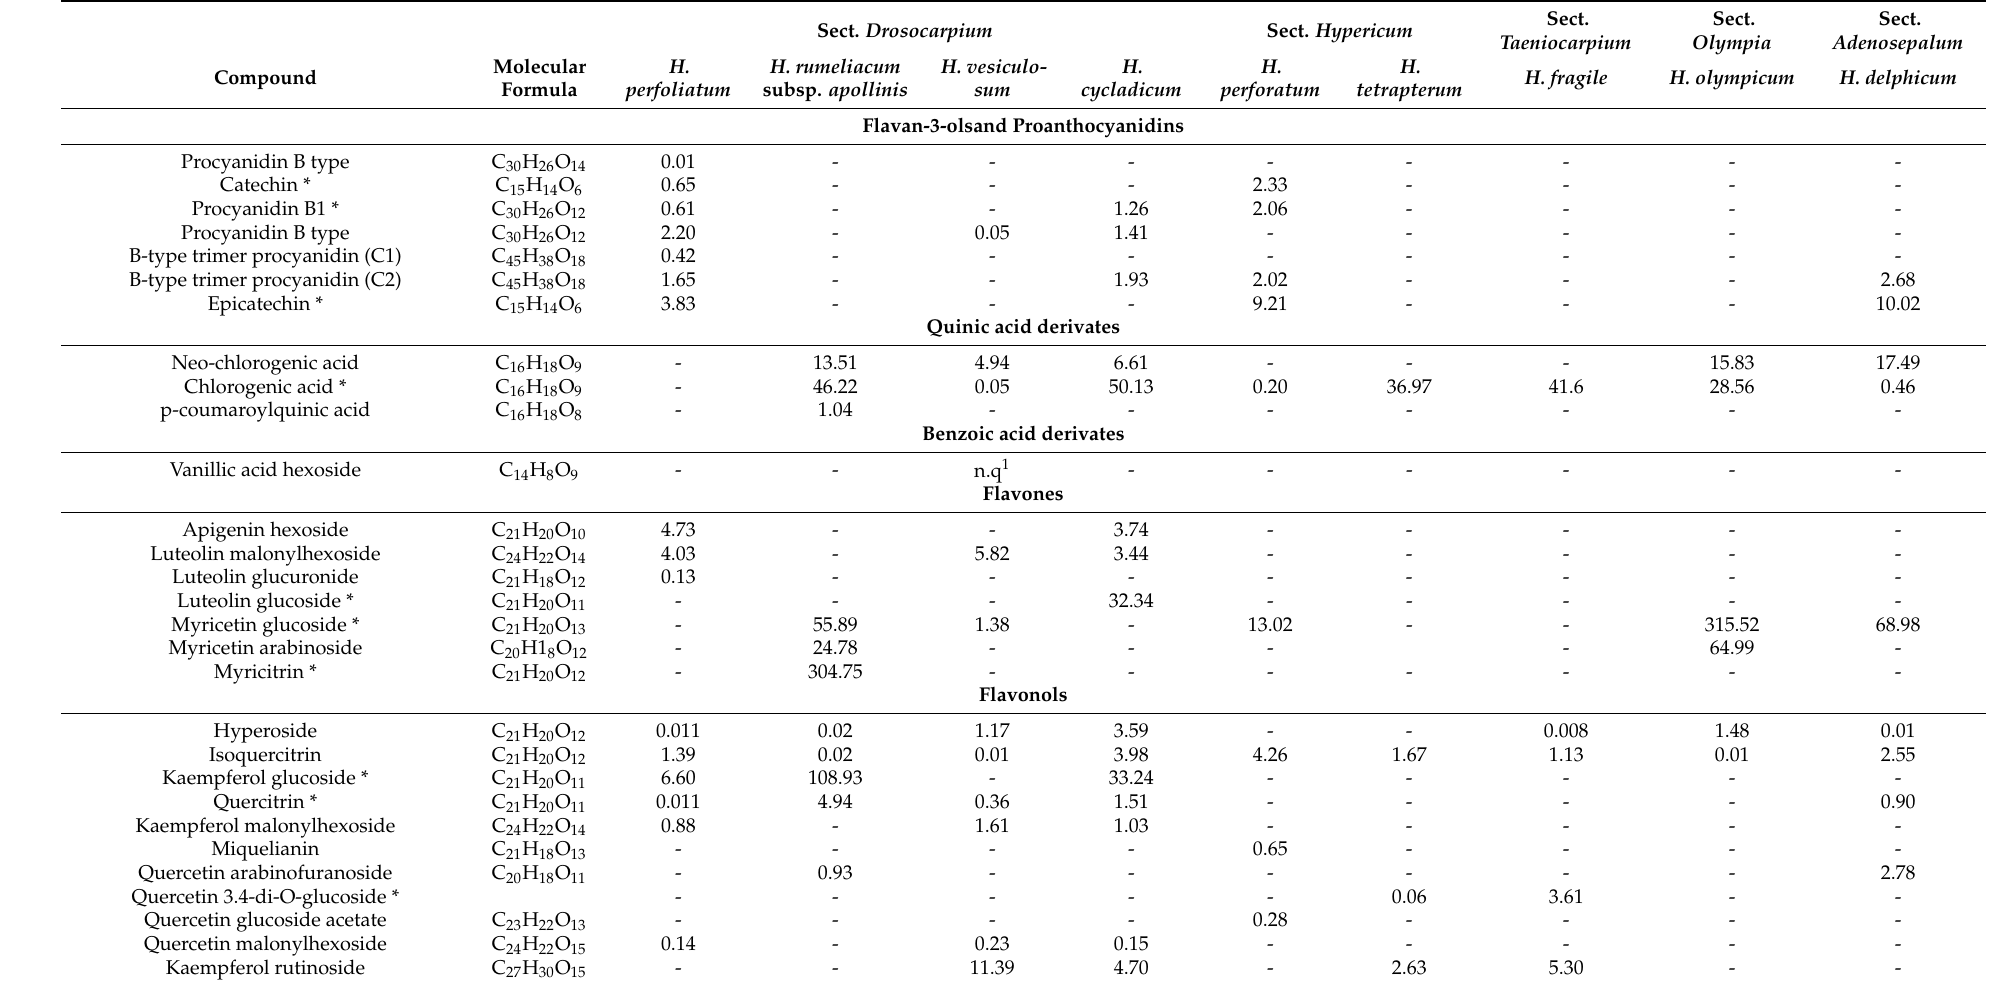
Table 1. Phytochemical analysis of Hypericum extracts expressed as mg/g of dry